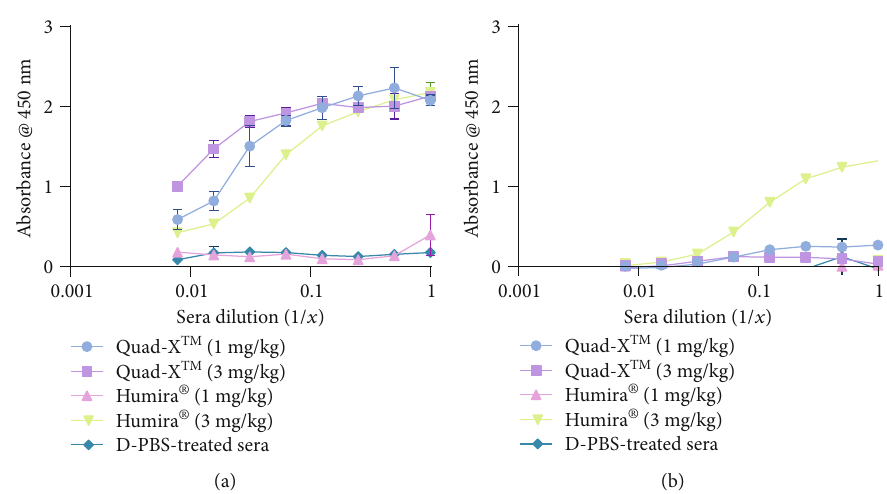
Figure 2: Direct and indirect-binding ELISA for detecting functional serum anti-TNF- α drugs and nonneutralising mouse ADA . (a) Direct- binding ELISA of serum samples to 2 μ g/mL hTNF- α coated wells, with functional drug binding determined using an anti-human IgG antibody- (Fc speci fi c) peroxidase. (b) Indirect-binding ELISA capturing nonneutralising mouse ADA to anti-hTNF- α drugs. ELISA wells are coated with 2 μ g/mL hTNF- α , and nonneutralising mouse ADA was detected using an anti-mouse IgG antibody- (whole molecule) peroxidase. All serum samples were randomly pooled and diluted at 1 :20 in sterile PBS, pH7.4. The results shown are the mean ± SD ( n = 2 with two replicates per